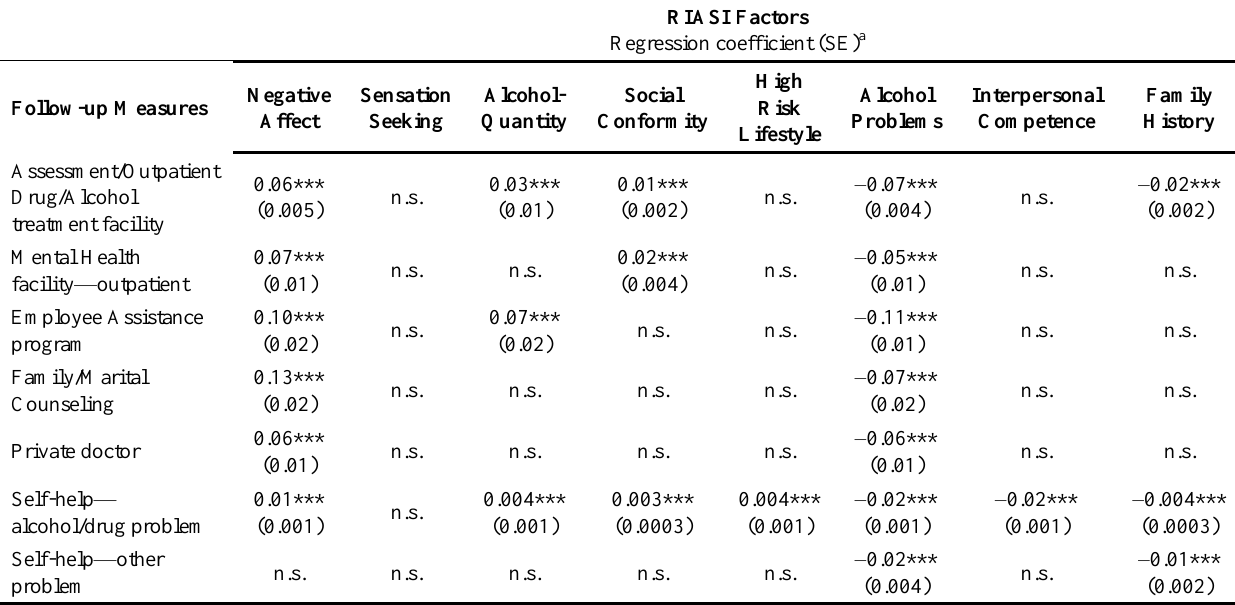
Table 4. Association between the RIASI factors and use of health services (no. sessions/visits/meetings attended) in the follow-up period. Back on Track remedial program clients (N = 22,298). RIASI